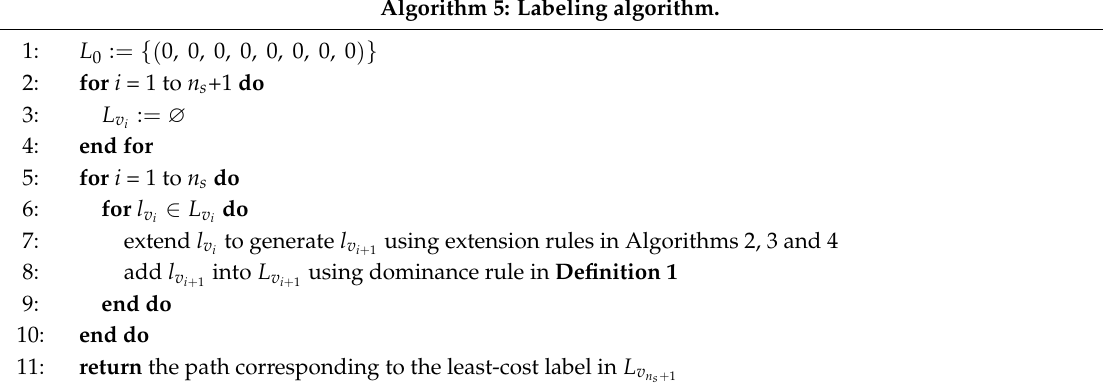
Algorithm 5: Labeling